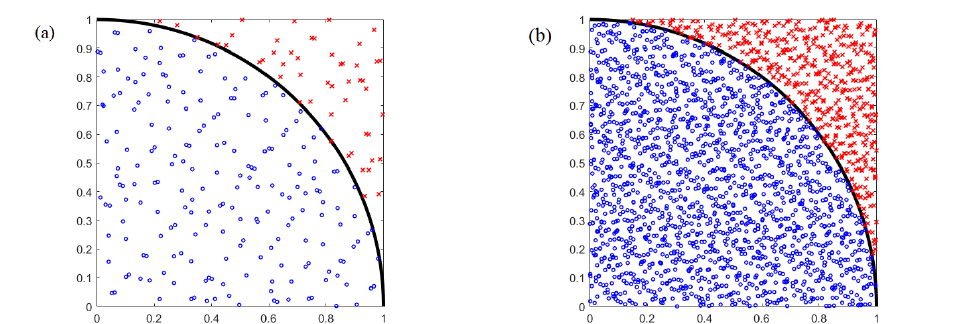
Figure 3. First ( a ) N = 1000; ( b ) N = 10,000 pairs of normalised arguments ( x n , y n ) , n = 1, . . . , N . Points inside the first quadrant of the unit circle (solid line) are represented by blue circles, while those falling outside the circle by red crosses.